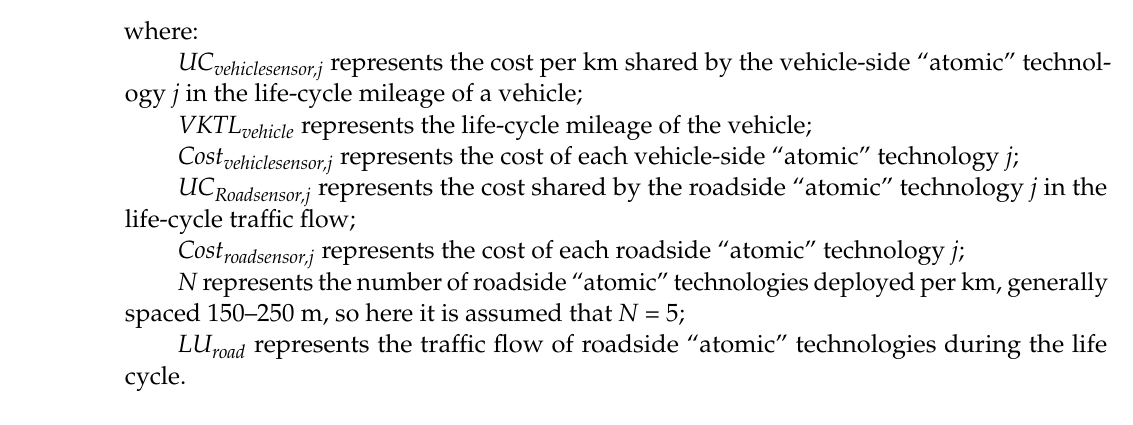
Table 4. Life-cycle shared costs of various “atomic” technologies. Sensor